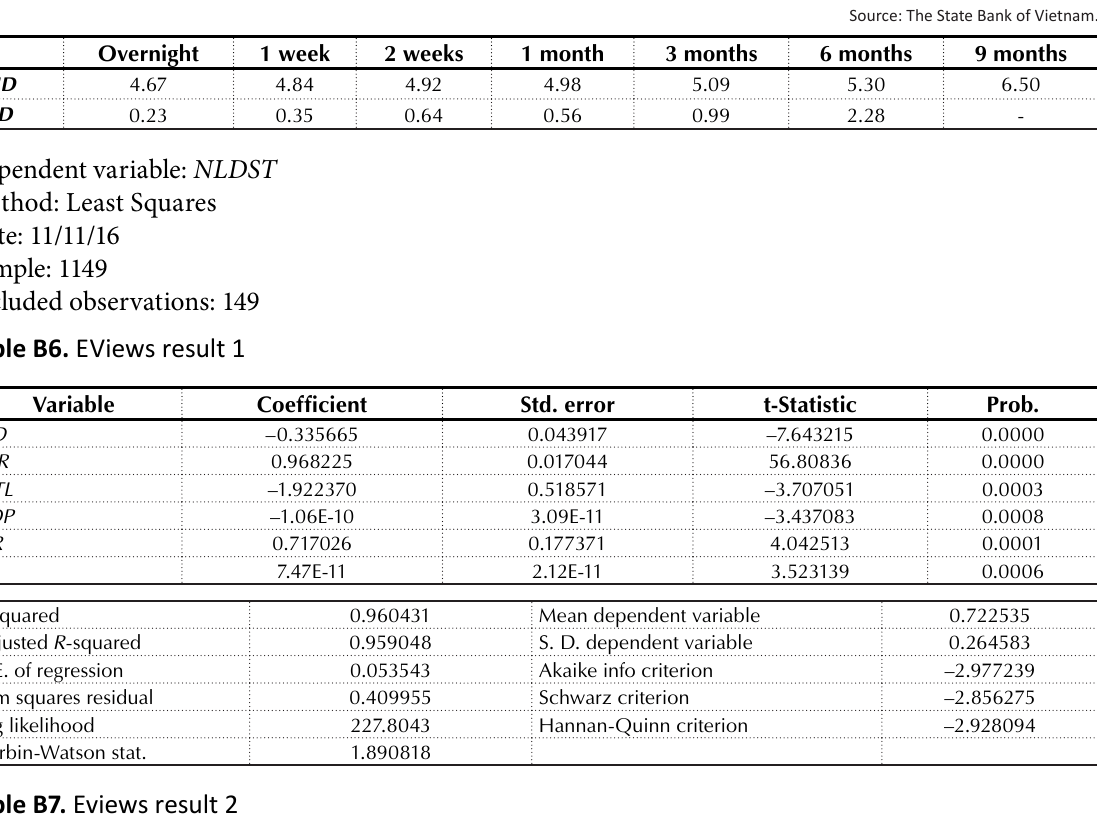
Table B5. The interbank rate from January 2015 to December 2015